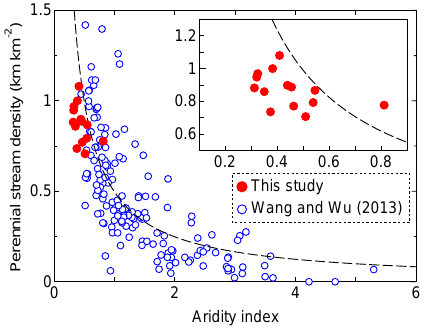
Figure 15. Perennial stream density ( D p ) and aridity index (PE /P ). The dashed line represents the fitted curve ( D p = 0 . 444 /( PE /P) ) from Wang and Wu (2013).